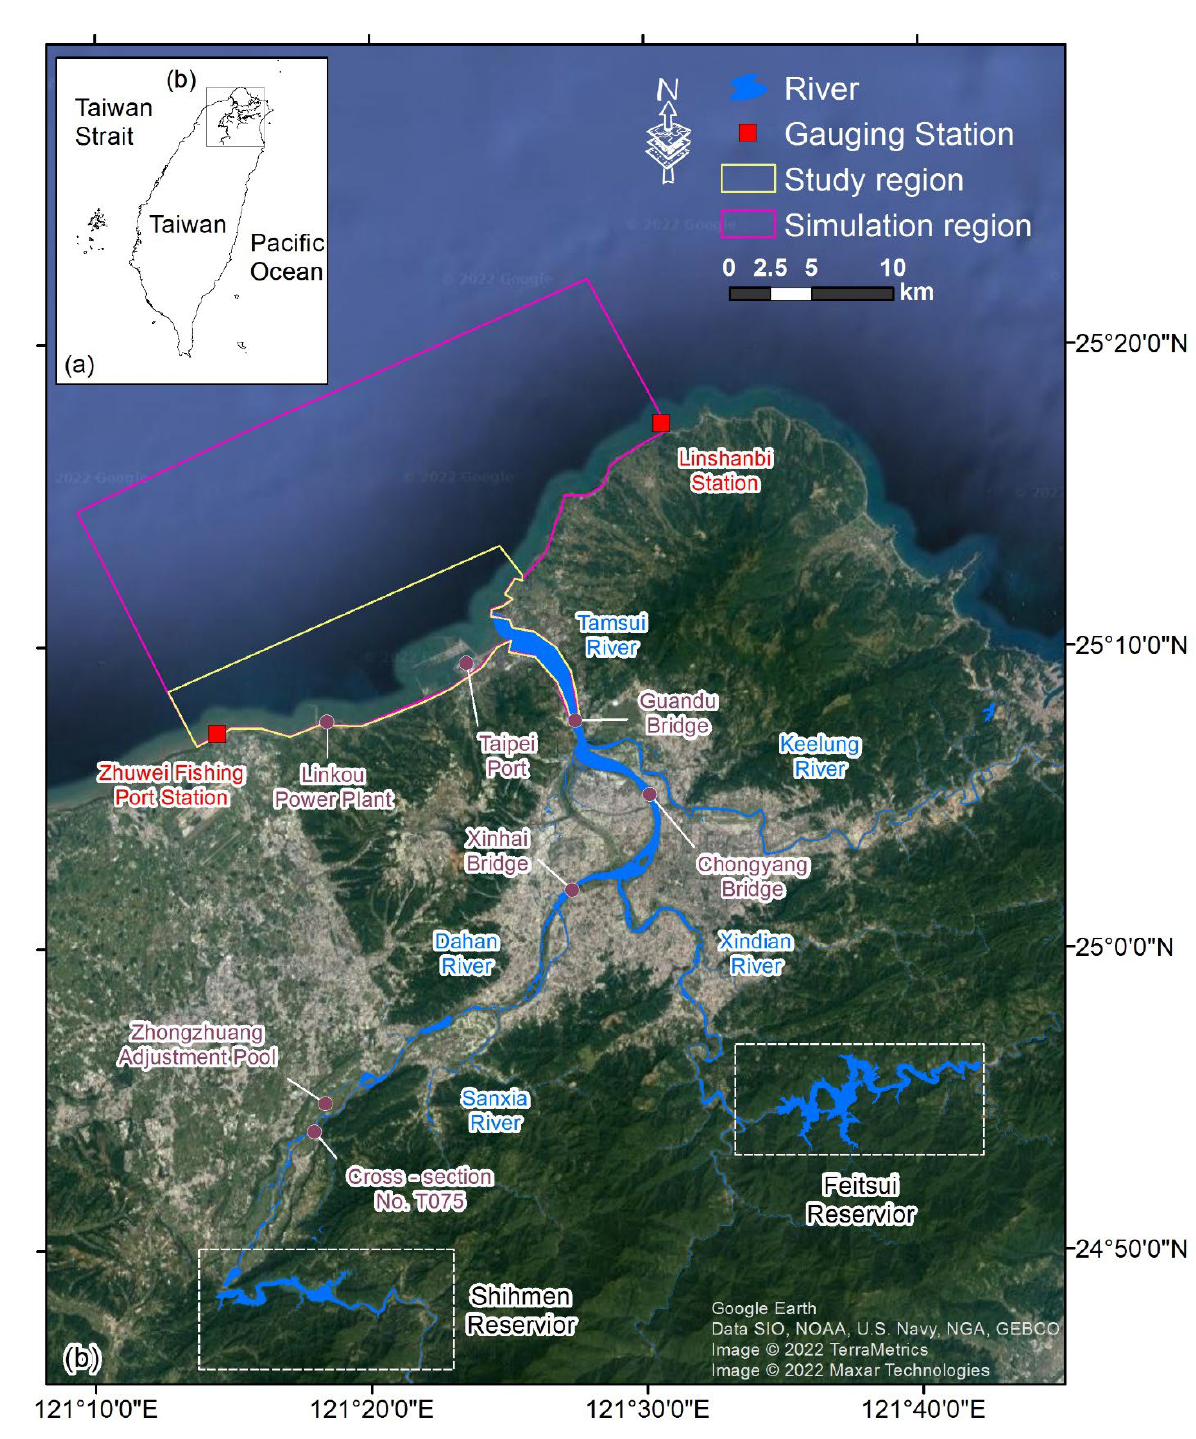
Figure 1. ( a ) Taiwan and ( b ) geographical location map of the Tamsui River basin.